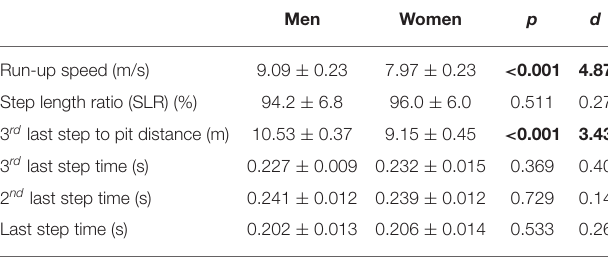
TABLE 2 | Mean SD values for run-up spatiotemporal ±